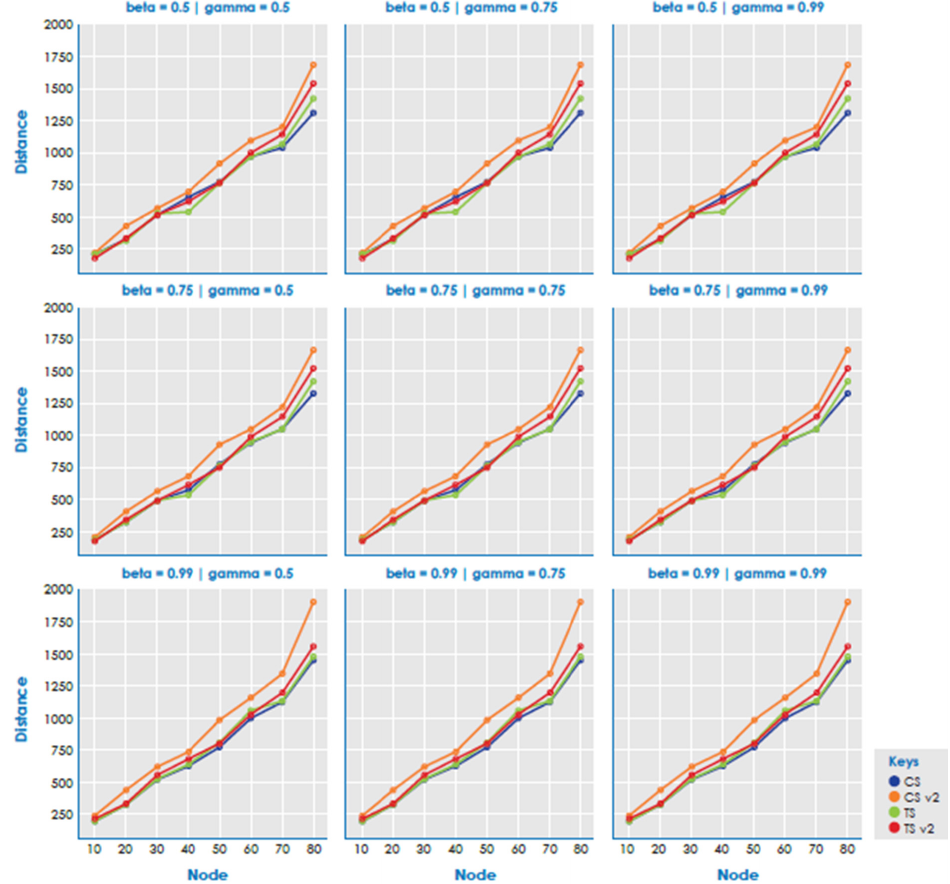
Figure 3. Total distance by methods. Α = 0.99 and supermarket = 60%.